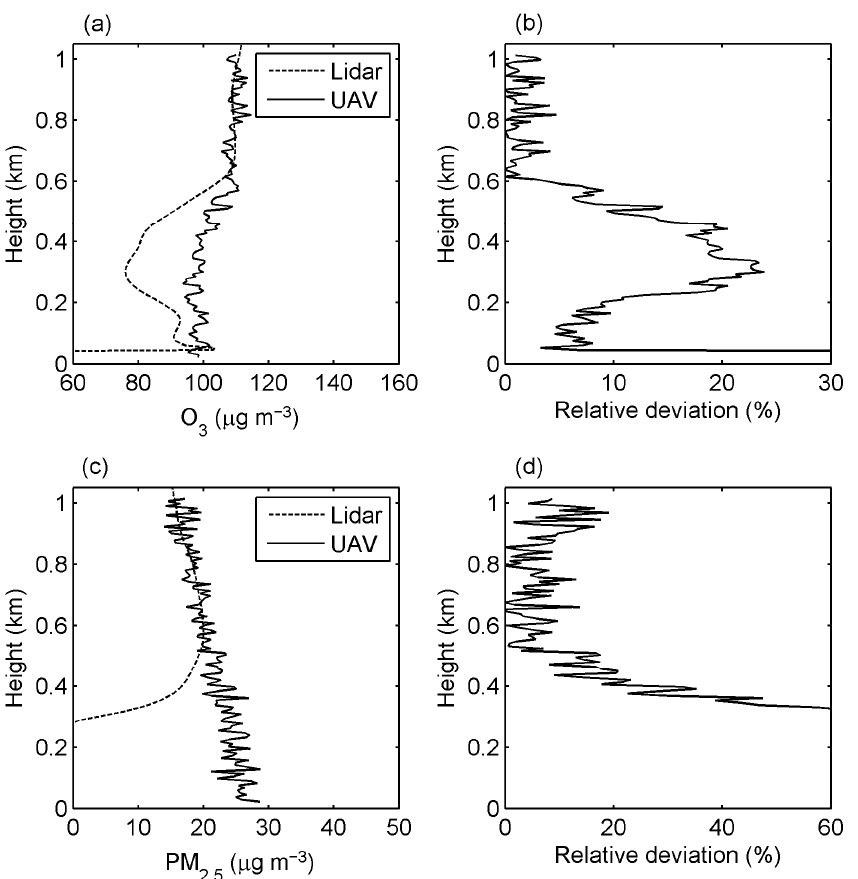
Figure 2. Comparison between Lidar and UAV observations. ( a ) O 3 profiles obtained by Lidar (dashed line) and UAV (solid line); ( b ) relative deviations of the O 3 profiles; ( c ) PM 2.5 profiles obtained by Lidar (dashed line) and UAV (solid line); ( d ) relative deviations of the PM 2.5 profiles.